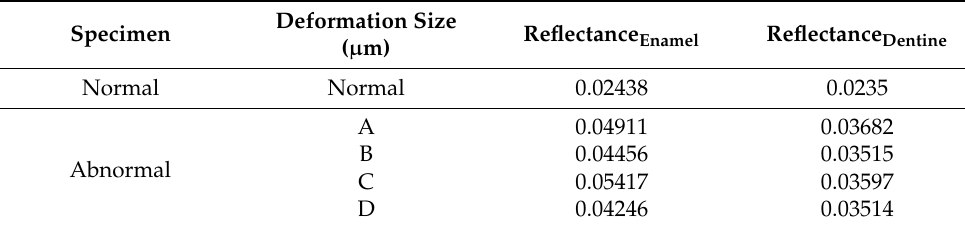
Table 2. Reflectance of signal with respect to the deformation.